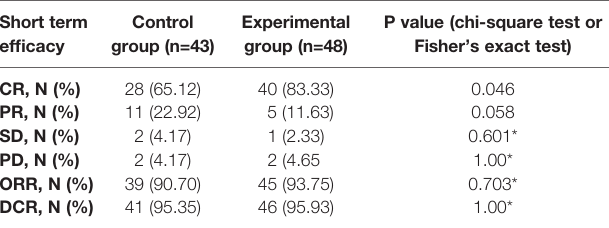
TABLE 2 | Comparison of short-term ef fi cacy between the two groups after treatment. Short term ef fi